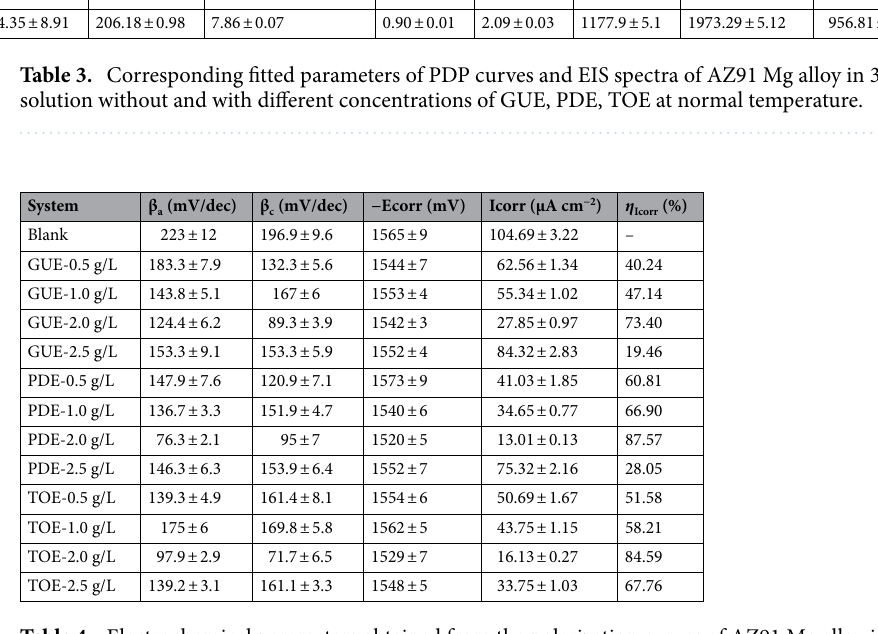
Table 4. Electrochemical parameters obtained from the polarization curves of AZ91 Mg alloy in 3.5 wt% NaCl solution without and with different concentrations of GUE, PDE, TOE at normal temperature.